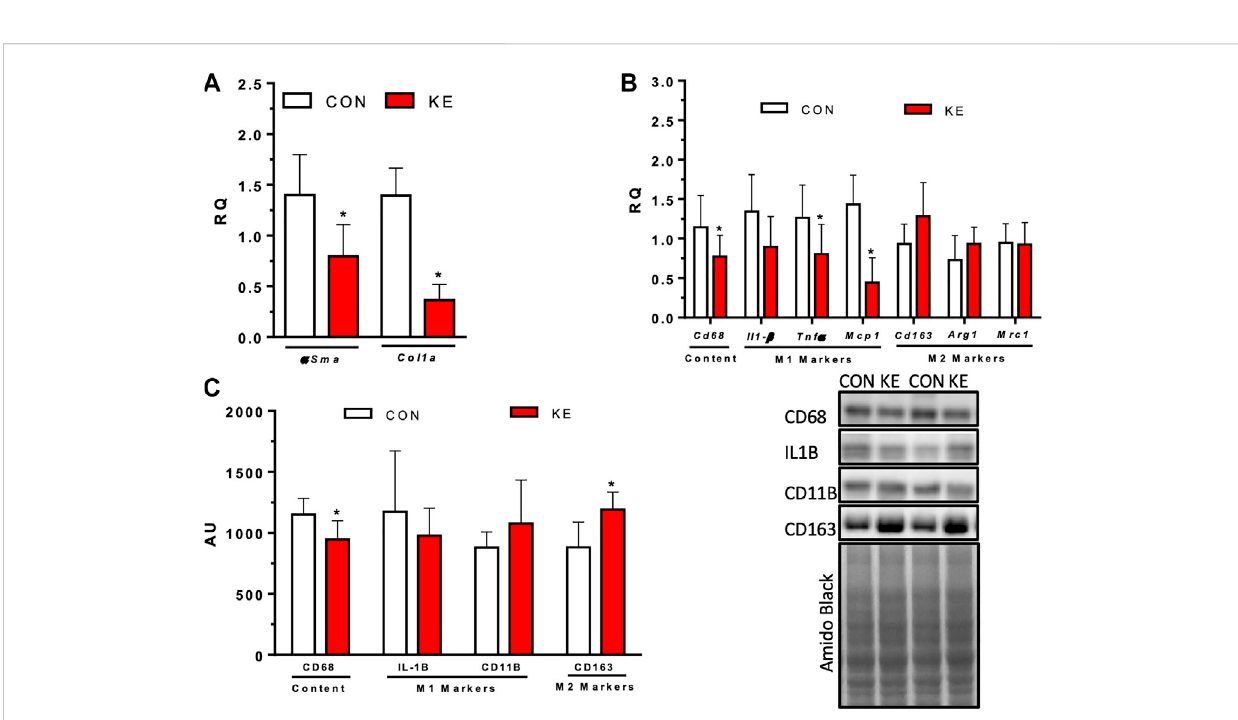
FIGURE 5 Markers of hepatic stellate cell activation, fi brosis, and hepatic in fl ammation after 9 weeks of CON or KE diets. (A) Hepatic markers of fi brosis, α Sma and Col1A1 mRNA expression. (B) mRNA expression of in fl ammatory hepatic marker Cd68 , pro-in fl ammatory hepatic M1 markers Il-1 β , Tnf α , and Mcp1 , and anti-in fl ammatory hepatic M2 markers Cd163, Arg1 , and Mrc1 . (C) Protein content of in fl ammatory hepatic marker CD68, pro-in fl ammatory hepatic M1 markers Il-1 β and CD11b, and anti-in fl ammatory hepatic M2 marker Cd163. Values are presented as means ± SD. p < 0.05, * indicates signi fi cant differences between